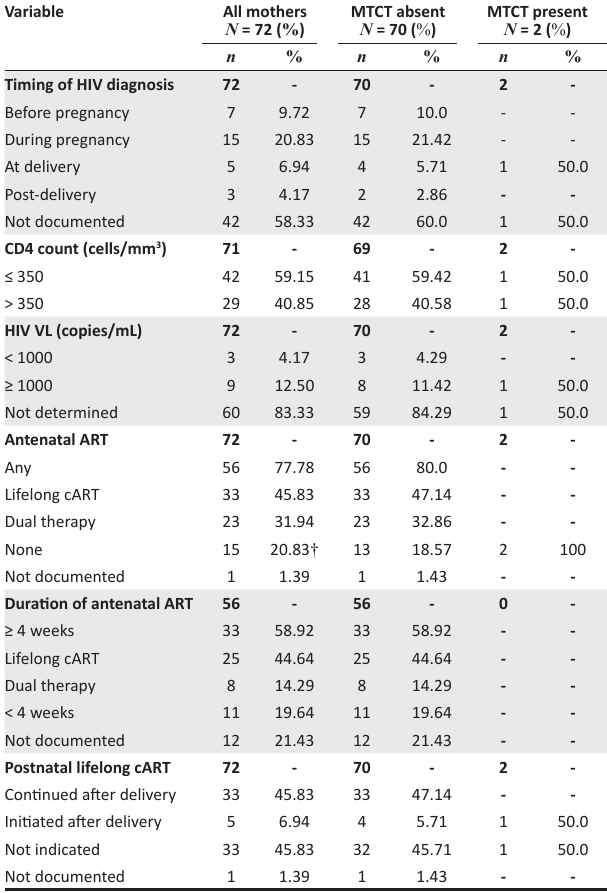
TABLE 3: Maternal human immunodeficiency virus characteristics